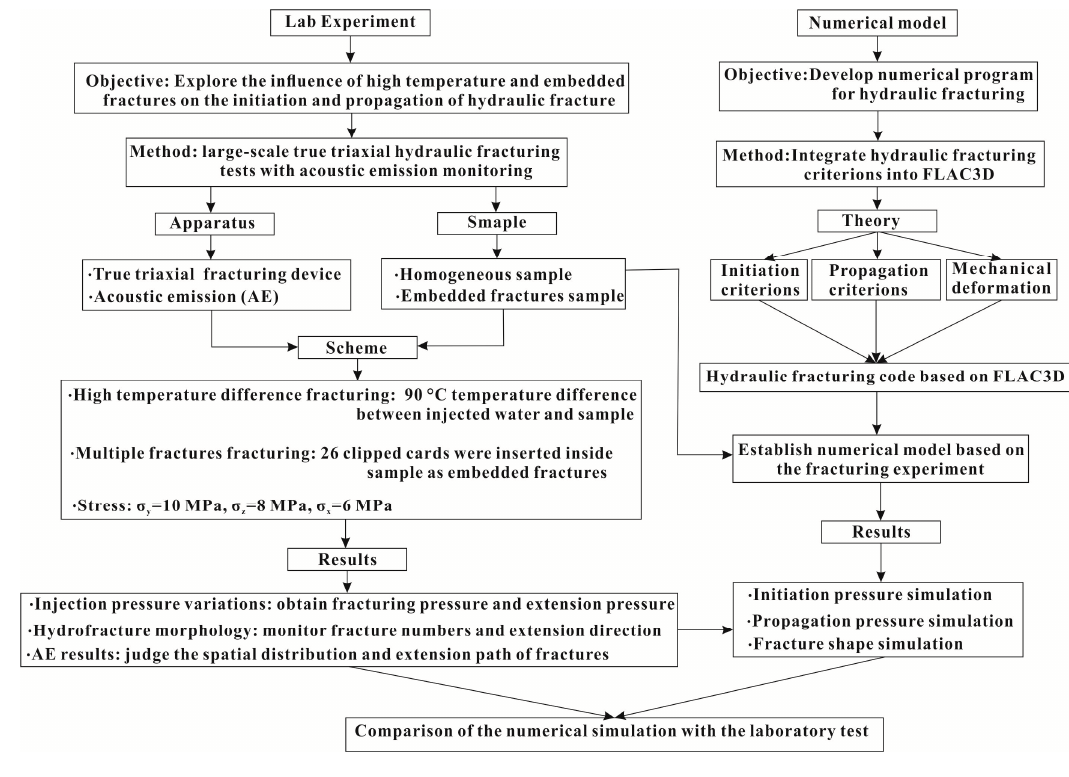
Figure 1. Methodological flowchart.